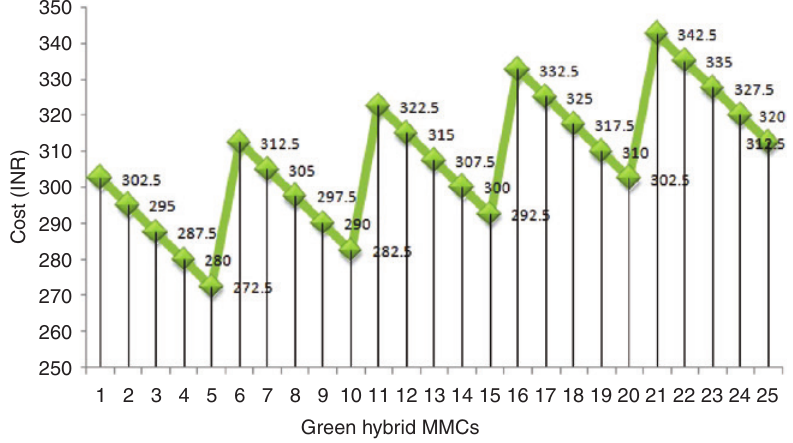
Figure 12: Cost estimation of hybrid green